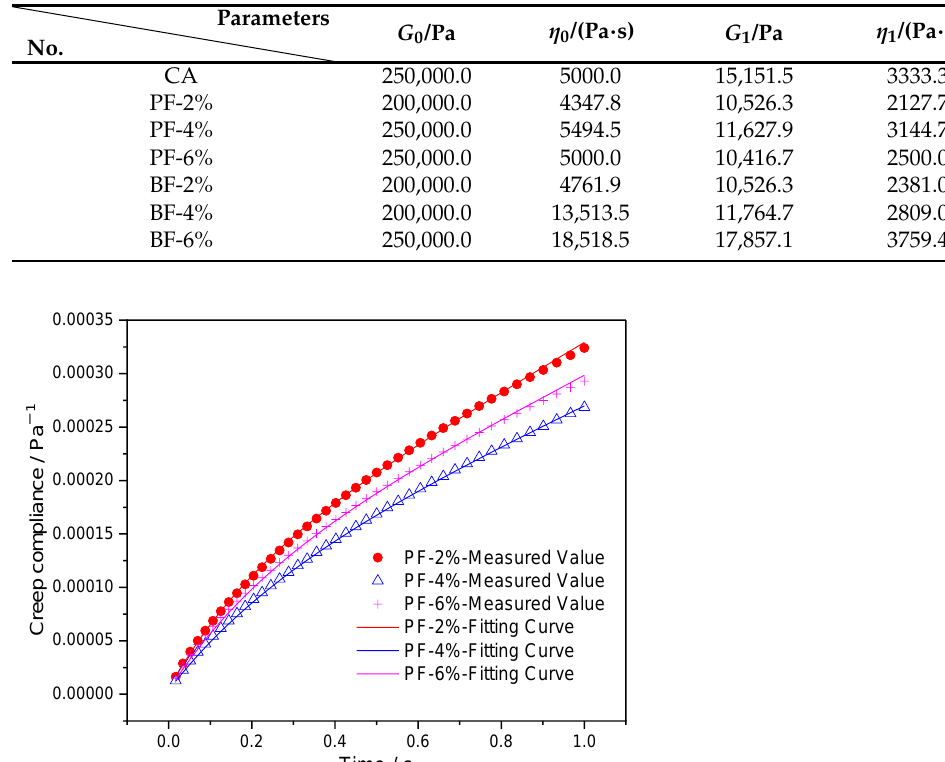
Figure 8. The measured and fitting results of creep compliance for composites with polyester fiber.